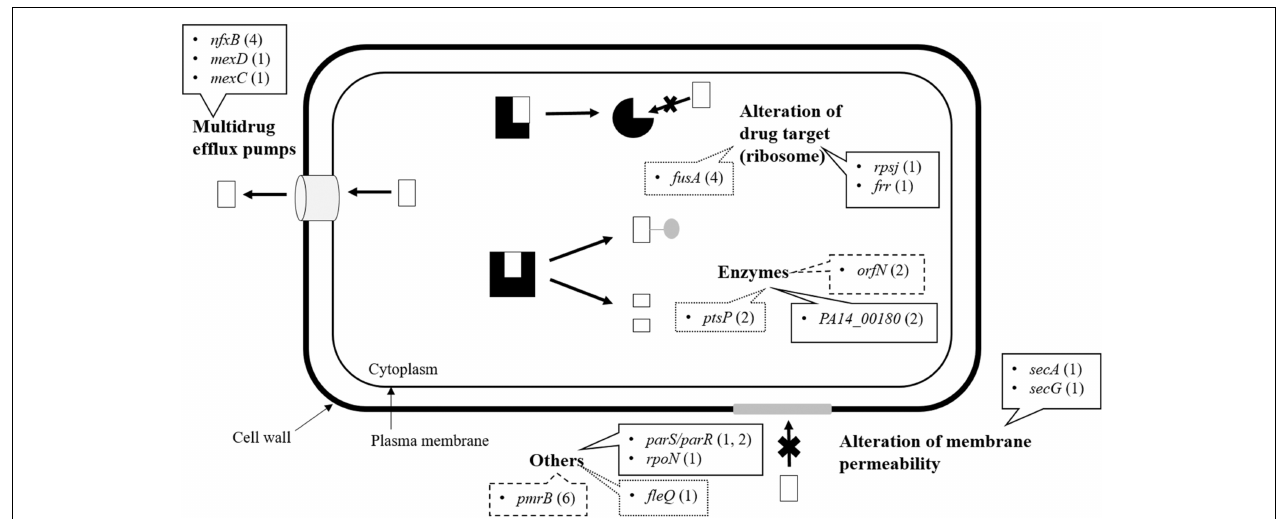
FIGURE 2 | Common and different genetic changes identified by whole-genome sequencing. Mutations detected by Illumina and verified by Sanger Sequencing in evolved P. aeruginosa PA14 at 32MIC tigecycline/tobramycin. Most mutations fell into the four major functional groups of resistance mechanism: multidrug efflux pumps, alteration of drug target, enzyme neutralization, and alteration of membrane permeability. Others that did not properly match any of these categories were entered the group “Others.” The line type indicates the drug providing the selection pressure: continuous line, tigecycline; dots, tobramycin; dashes, both treatments. The figures after the genes refer to the number of different genetic changes found in each. These values also inform about the number of biological replicates in which a particular gene mutated, with the exceptions of rpsJ (only one type of mutation) and orfN (two different mutations that appeared in every evolved